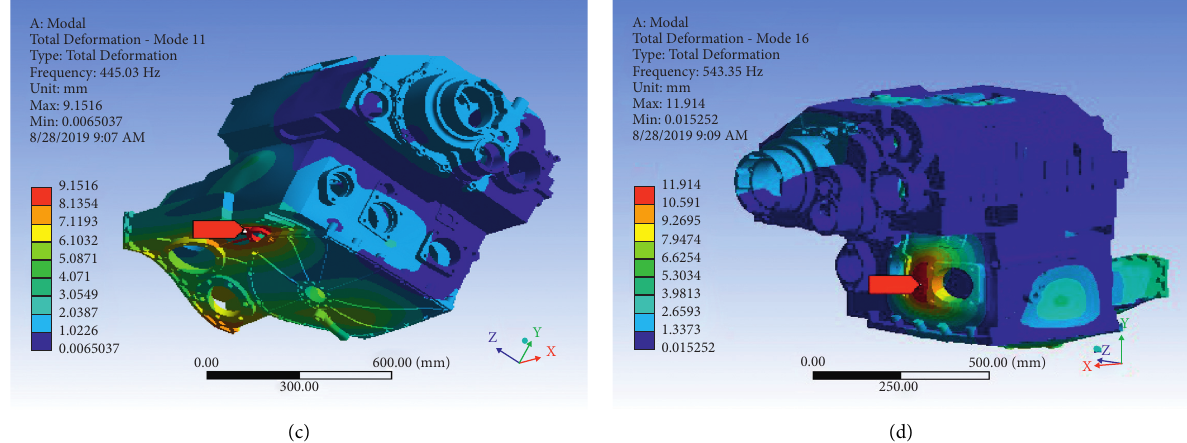
Figure 8: Modal diagram of the housing. (a) The 7-th housing mode. (b) The 8-th housing mode. (c) The 11-th housing mode. (d) The 16-th housing mode.